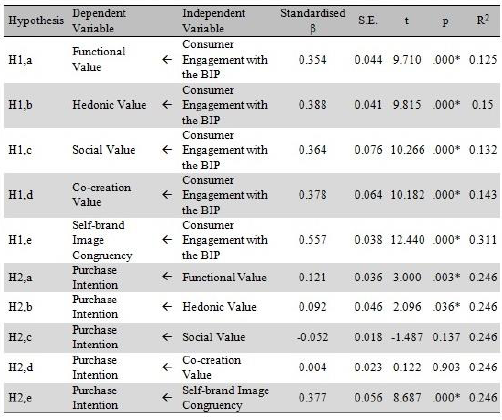
Table 2: Estimation Statistics of the First Structural Equation Model